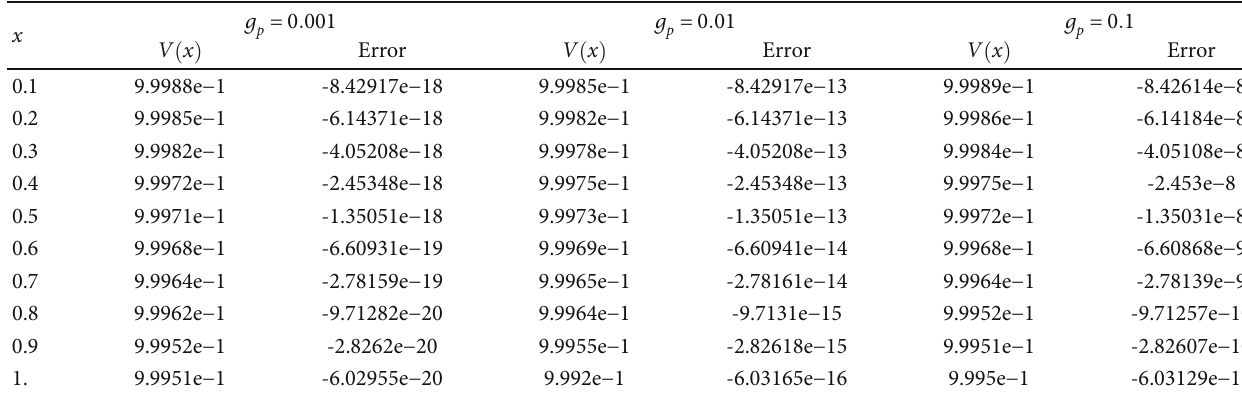
Table 3: Results for β in lifting case where α = 0 : 99and g